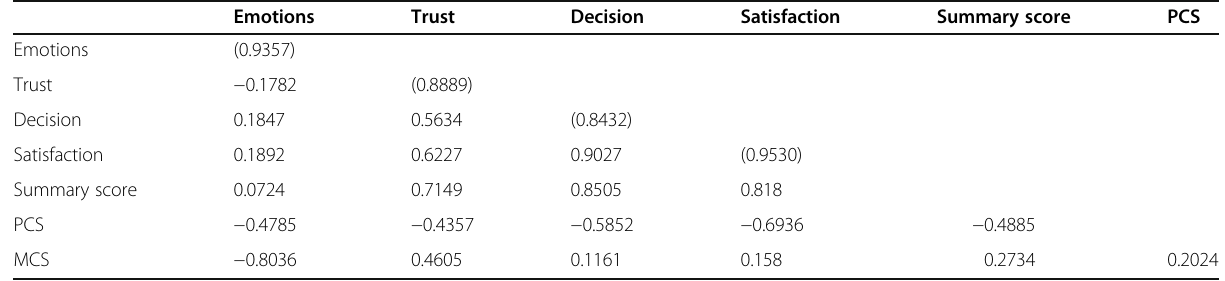
Table 5 Correlation of scales, summary score, and construct validity scores. Cronbach ’ s alpha for multi-item scales given on the diagonal (in